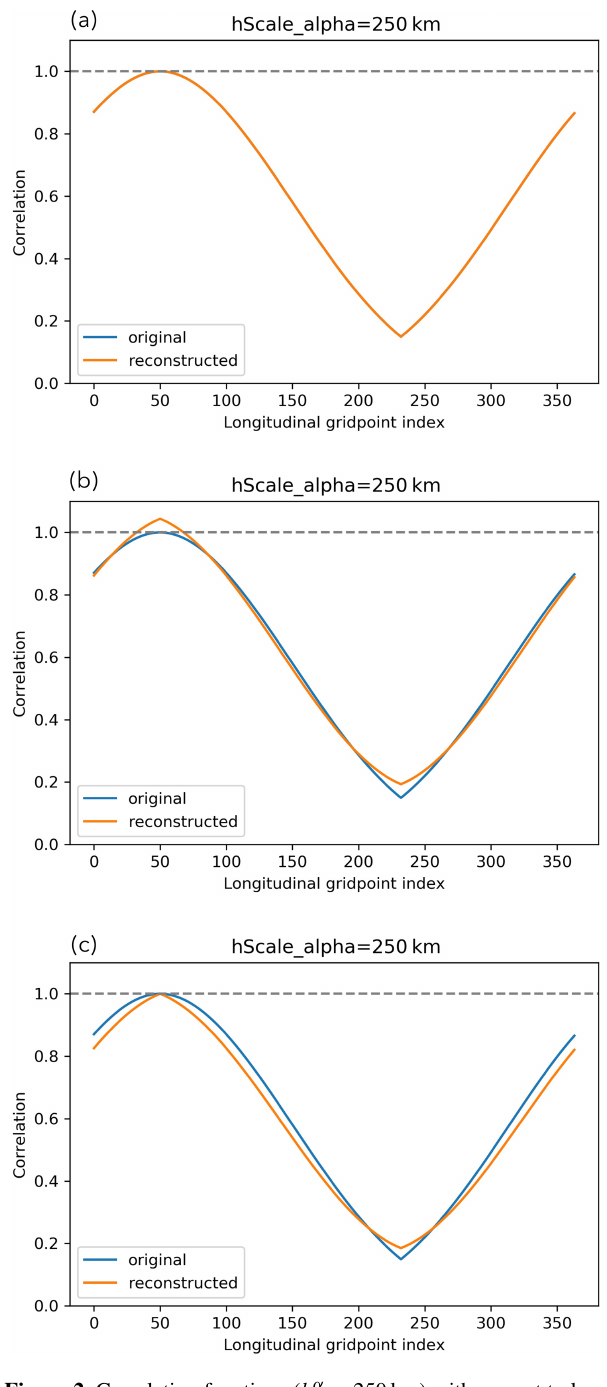
Figure 2. Correlation functions ( h α = 250km) with respect to lon- gitudinal grid point 50 for an ABC-DA system with 364 longitudi- nal grid points and 1.5km horizontal grid. The implied correlation functions (orange) are reconstructed from (a) all eigenvectors and eigenvalues of the eigendecomposition of L horiz , (b) only eigenvec- tors with non-negative eigenvalues, (c) only eigenvectors with non- negative eigenvalues that are scaled to restore initial total variance, and compared with the original Gaspari–Cohn function